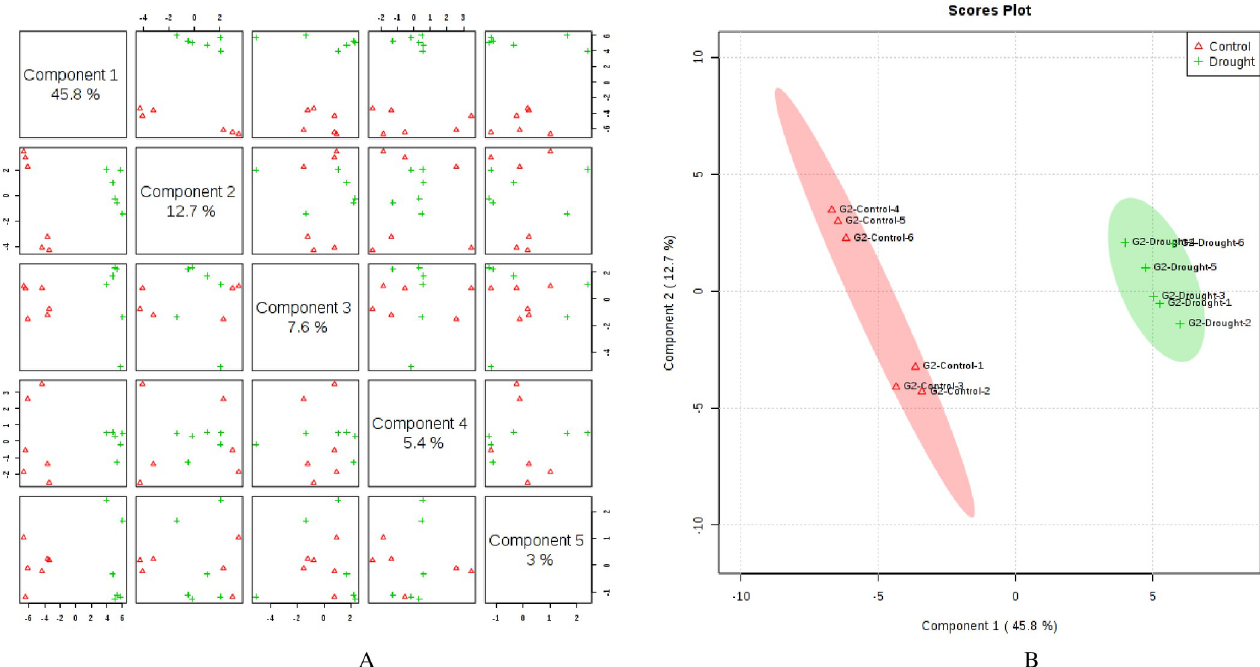
Fig 4. Partial least square discriminant analysis (PLS-DA) (A) and 2D Scores plot (B) in roots of AGS2038 under control (irrigated) and drought conditions. Samples at control and drought treatments did not overlap with each other indicating an altered state of metabolite levels in the wheat roots.